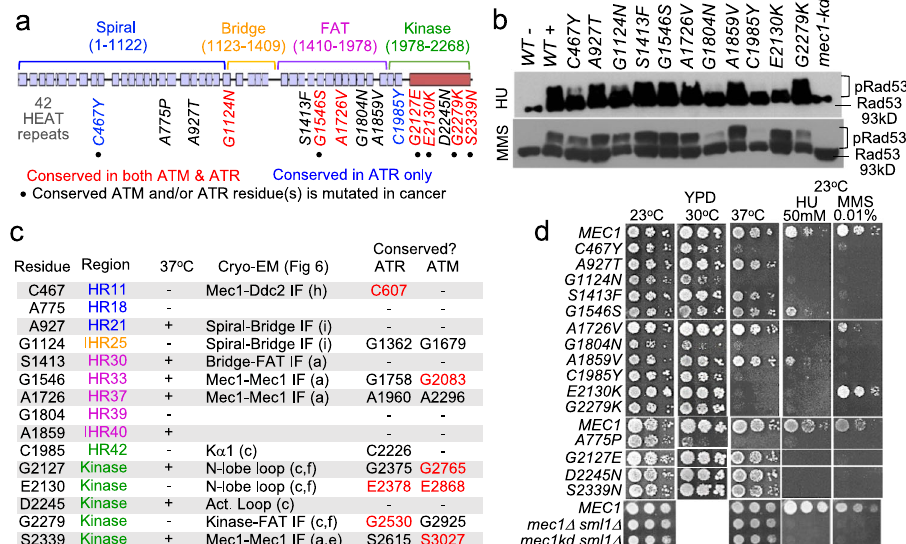
Fig. 5 An unbiased genetic screen identi fi es conserved Mec1 residues required for the DDR. a Mec1 comprises 42 HEAT repeats and a kinase domain 45 . An unbiased genetic screen identi fi ed 15 residues critical for mediating resistance to HU and/or MMS (Supplementary Fig. 5a, Supplementary Table 2, and Supplementary Data 5). Red: residue is conserved in both ATM and ATR. Blue: conserved in only ATR. (cid:129) The conserved ATM and/or ATR residue is mutated in cancer ( c ; Supplementary Data 3, 4, and 6; http://cbioportal.org). b Impact of the indicated mec1 allele on HU- and MMS-dependent Rad53 activation. Western blot analysis was performed using a Rad53 antibody that detects both unphosphorylated and phosphorylated species (EL7.E1) 35 . “ WT − ” : untreated negative control sample. “ WT + ” : positive control sample. “ mec1-kd ” : a kinase dead mutant in a sml1 Δ suppressor mutation background used as a control. Locations of the unphosphorylated (93kD) and phosphorylated Rad53 species are indicated (Supplementary Fig. 5d). c Summary of the results presented in b and d , Fig. 6 and Supplementary Fig. 5c. Region: the colors correspond to the four domains in a . HR H EAT R epeat unit. IHR I nter- HR ; the loop region following the indicated HR unit. 37°C: growth at 37°C ( d ). Cryo-EM (Fig. 6): location of the indicated residue in the Mec1 – Ddc2 enzyme complex. The letters in the parenthesis corresponds to the relevant panel in Fig. 6. IF interface. Conserved?: the ATR/ATM residue corresponding to the indicated Mec1 residue (Supplementary Data 6). -: not conserved. Residues written in red are mutated in cancer (Supplementary Data 3, 4, and 6; http://cbioportal.org). d Impact of temperature, HU, and MMS on the indicated mec1 strains ( “ Methods ” ). The mec1 Δ and mec1-kd control strains are in a sml1 Δ suppressor mutation background necessary to maintain viability; all other mec1 mutants are in a SML1